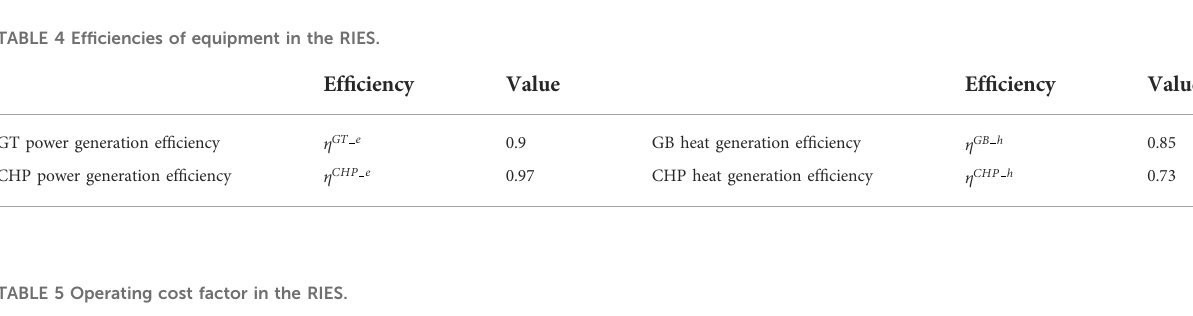
TABLE 5 Operating cost factor in the RIES. Equipment